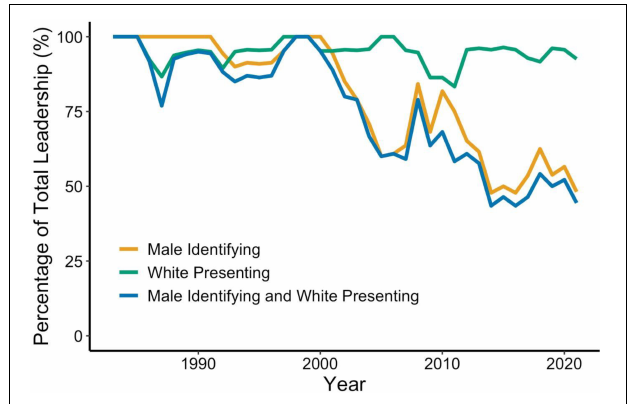
FIGURE 4 | The percentage of AES leaders in any given year that identified as male, are white presenting, or